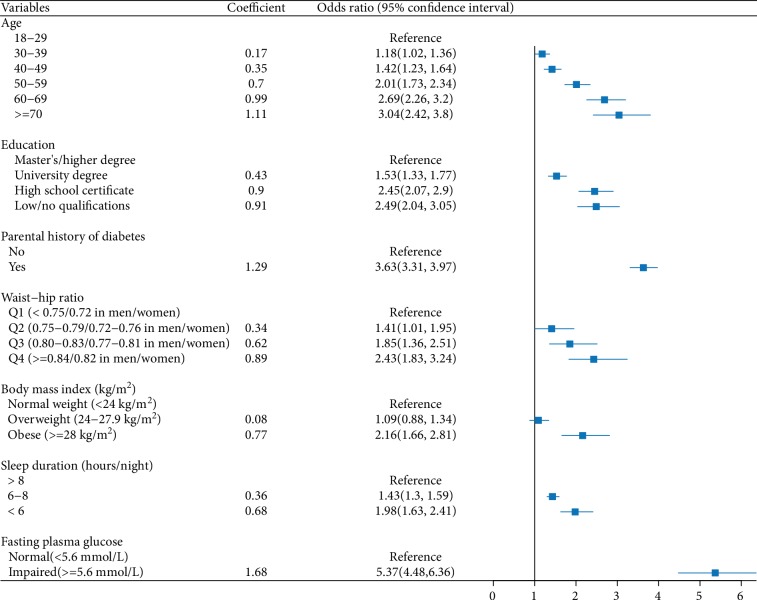
Variables involved in the multivariable logistic regression after forward selection.